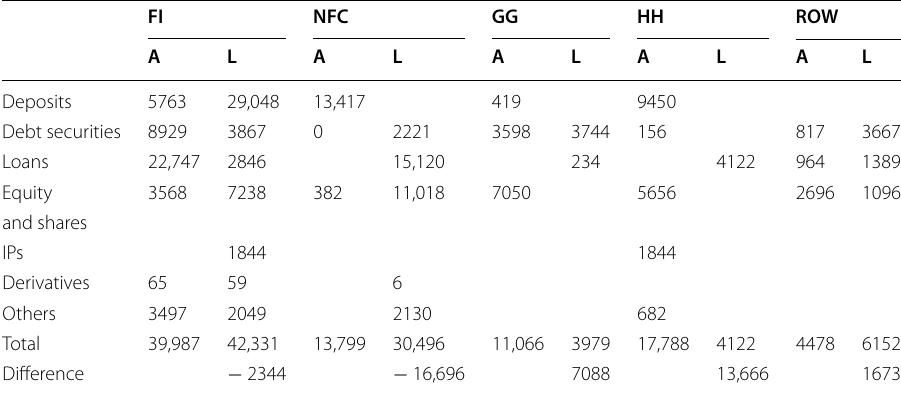
Source: created by authors using the Almanac of China’s Finance and Banking 2016. A: assets; L: